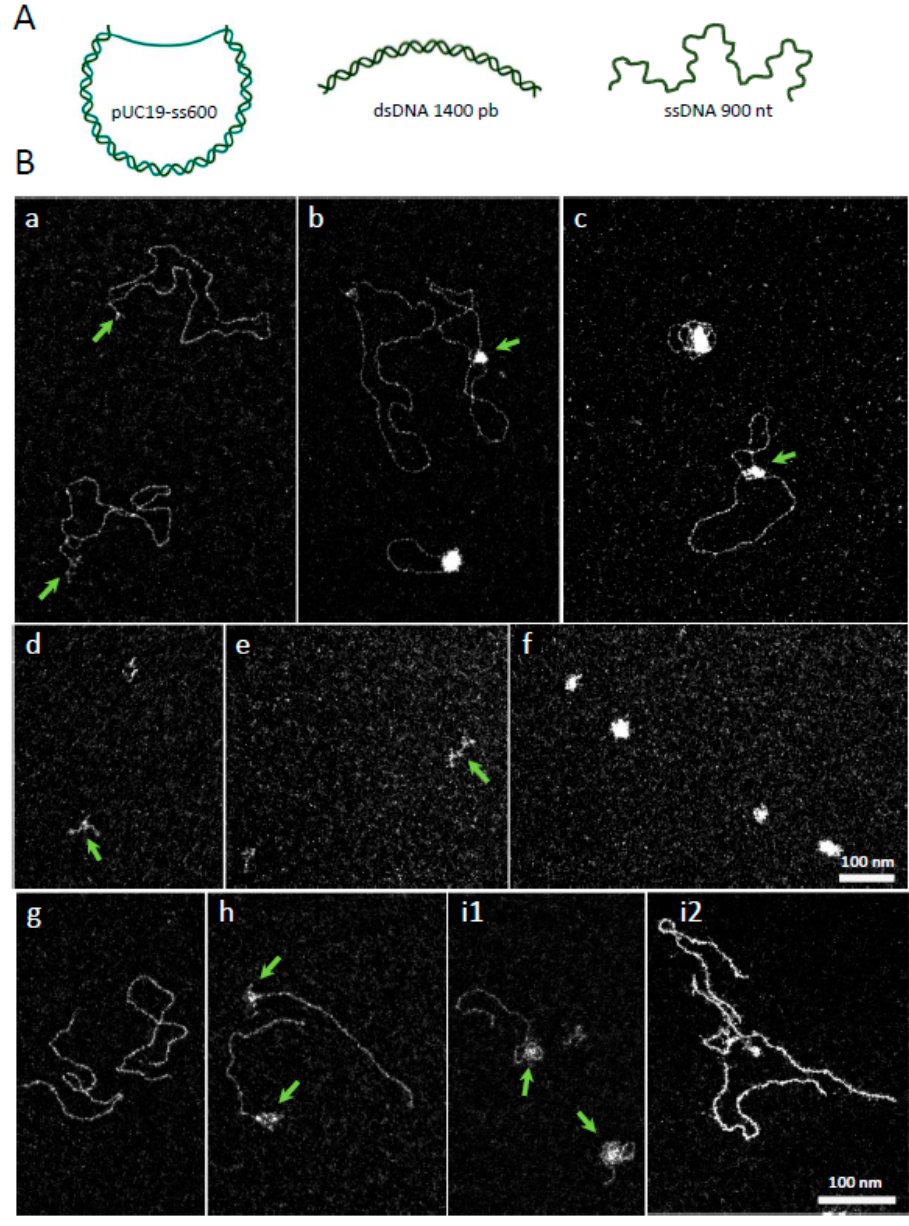
Figure 2. Vc DciA interacted preferentially on single-stranded areas of DNA or at the ss/ds junction. ( A ) Schematic representation of DNA tested for interaction with Vc DciA by electron microscopy. The pUC19 plasmid was modified to expose 600 unpaired nucleotides (pUC19-ss600). The linear double- and single-stranded DNA were 1440 base pairs (bp) and 900 nucleotides (nt), respectively. Created with BioRender.com ( B ) TEM images of Vc DciA-DNA complexes in dark-field imaging mode. ( a ) pUC19-ss600 naked DNA (control) where ssDNA is indicated by arrows. ( b , c ) Vc DciA (40 nM) first interacted with ssDNA of pUC19-ss600 (arrows) and then invaded the dsDNA. Length of free dsDNA decreased. ( d – f ) Interactions of Vc DciA with ssDNA at 40 nM (arrow) ( e ) and 100 nM ( f ), compared to the control (arrow) ( d ). ( g , h , i1 , i2 ) Interactions of Vc DciA (40 nM) (arrows) ( h ) and 100 nM (arrows) ( i1 , i2 ) with dsDNA, compared to the control ( g ). Vc DciA is bound to DNA ends, and such interactions can propagate along the dsDNA ( i2 ). Scale bars correspond to 100